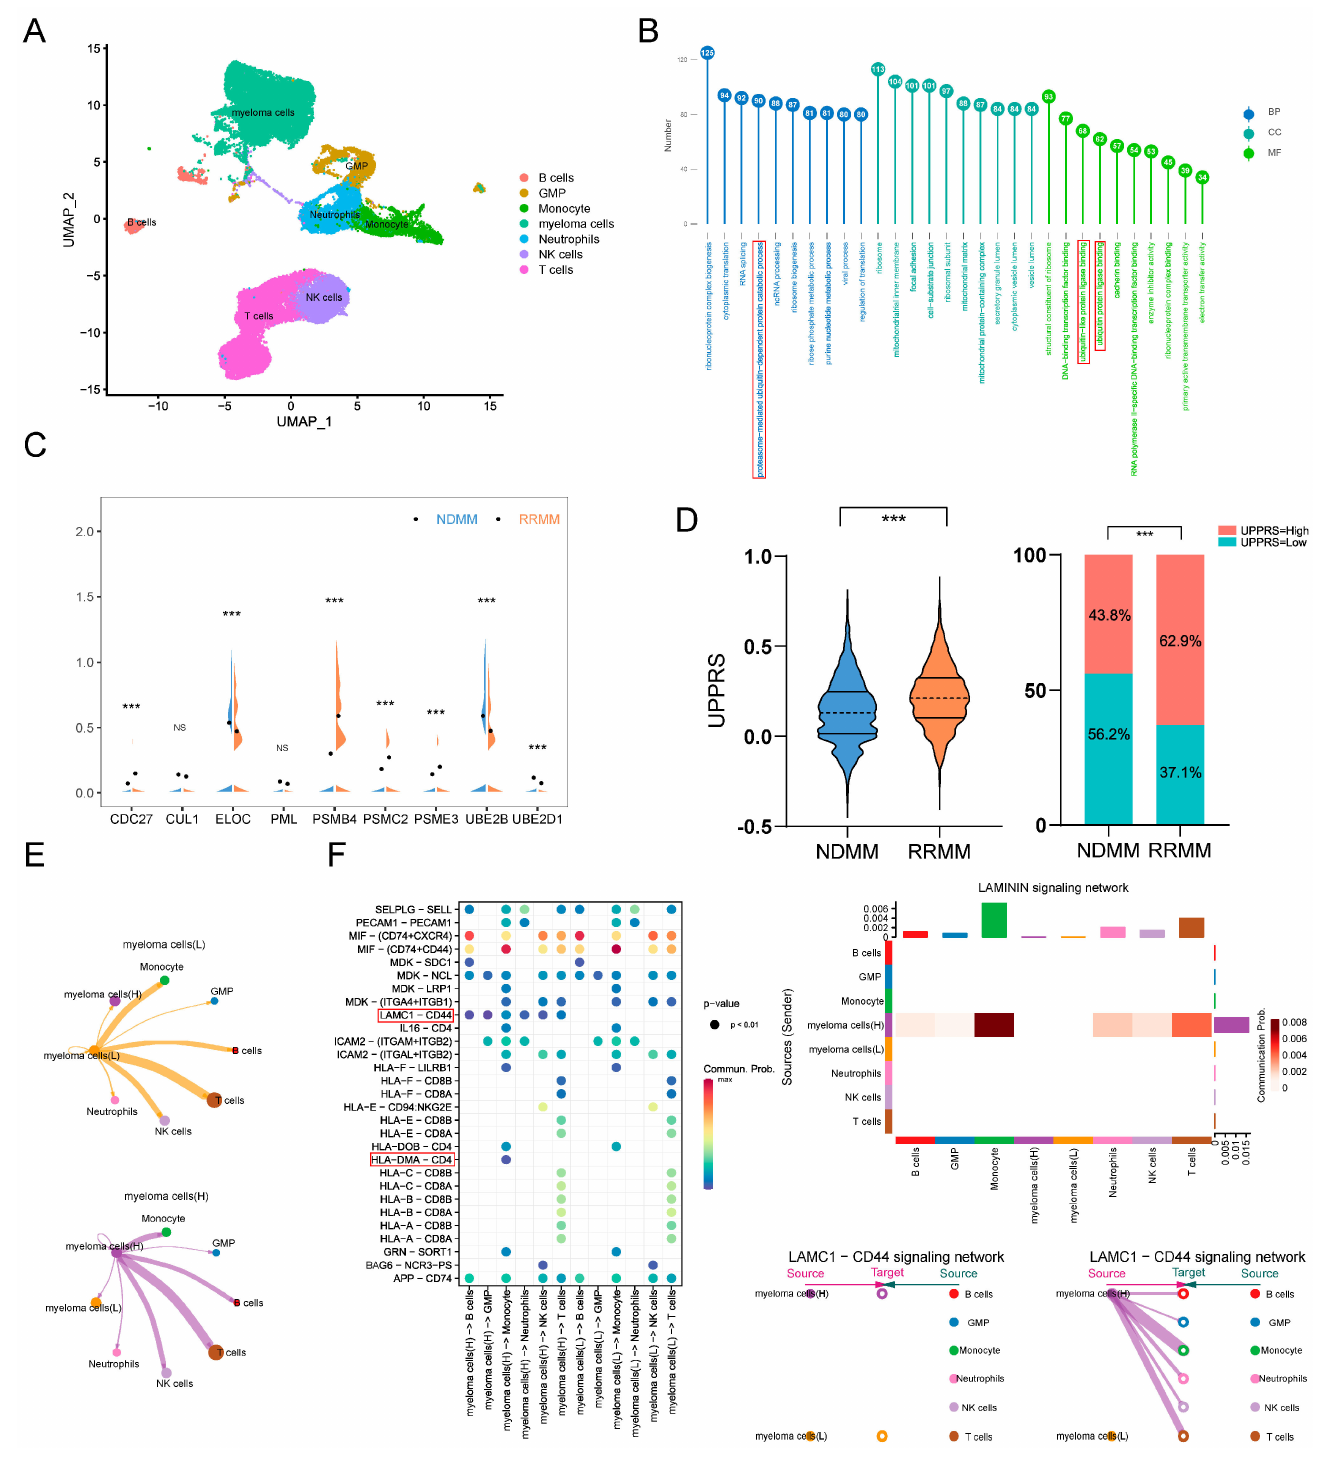
Figure 7. UPPRS analysis at sc − RNA level. ( A ) UMAP plot of 40,675 cells from 3 NDMM and 3RRMM samples. ( B ) GO enrichment analyses on the DEGs between NDMM and RRMM myeloma cells. ( C ) The comparison of 9 UPPGs in UPPRS between NDMM and RRMM myeloma cells. ( D ) The UPPRS in NDMM and RRMM myeloma cells. ( E ) Strength of the cell − cell communications among high − UPPRS, low − UPPRS myeloma cells, and other immune cells. ( F ) Ligand − receptor in the communication of two subtypes of myeloma cells to immune cells. Myeloma cells (H)—-high-UPPRS myeloma cells; Myeloma cells (L)—-low-UPPRS myeloma cells. *** p < 0.001. ns: no